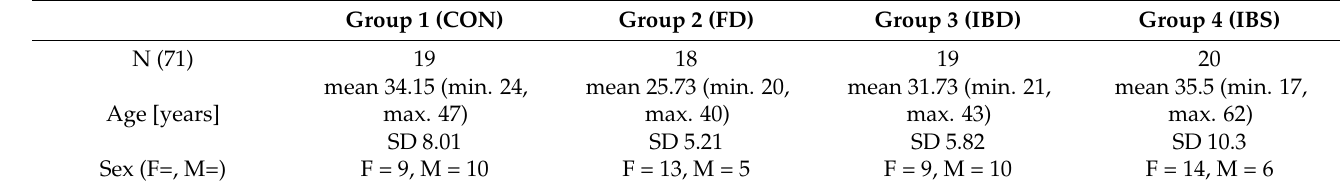
Table 1. General characteristics of the study and control group. Group: 1—control (CON), 2— functional dyspepsia (FD), 3—non-specific inflammatory bowel diseases (IBD), 4—irritable bowel syndrome